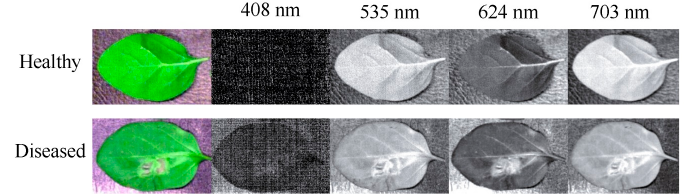
Figure 6. Gray images extracted from hyperspectral images.